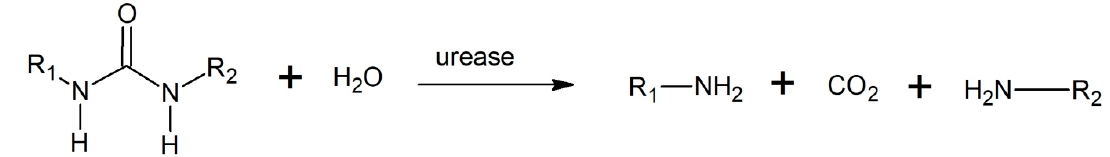
Figure 8. Hydrolysis of polyurethane by urease.